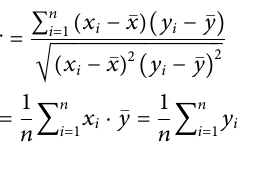
TABLE 1 | The scale and classi fi cation standard of landslides, collapses, unstable slopes, and debris fl ow.